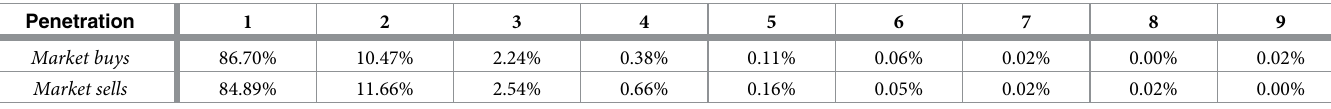
The proportions of orders with the penetration greater than 10 are zeros.